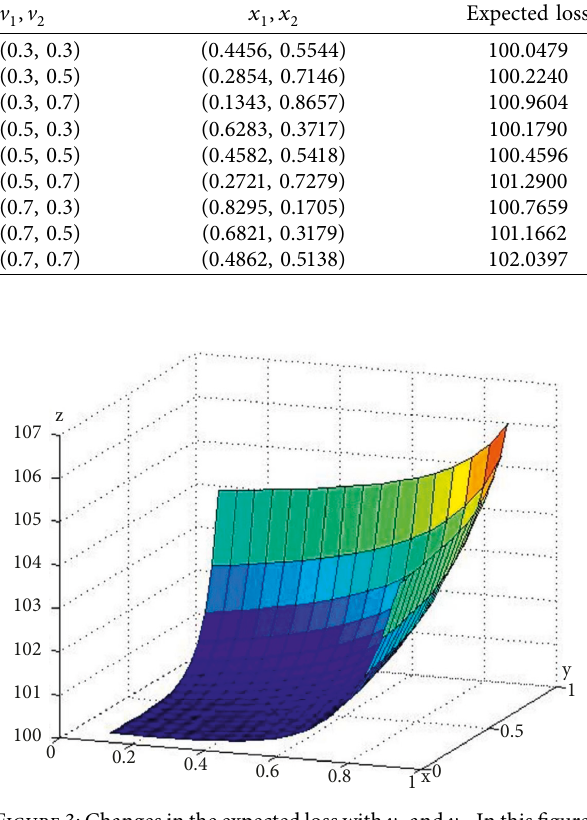
Figure 3: Changes in the expected loss with v and v . In this figure, 1 2 x axis denotes the probabilities that cities are invaded by illegal users when no funds are invested in the data influencing infor- ), y axis denotes the probabilities that cities are mation security ( v 1 invaded by illegal users when no funds are invested in the appli- cation software influencing information security ( v ), and z axis 2 denotes expected loss of smart